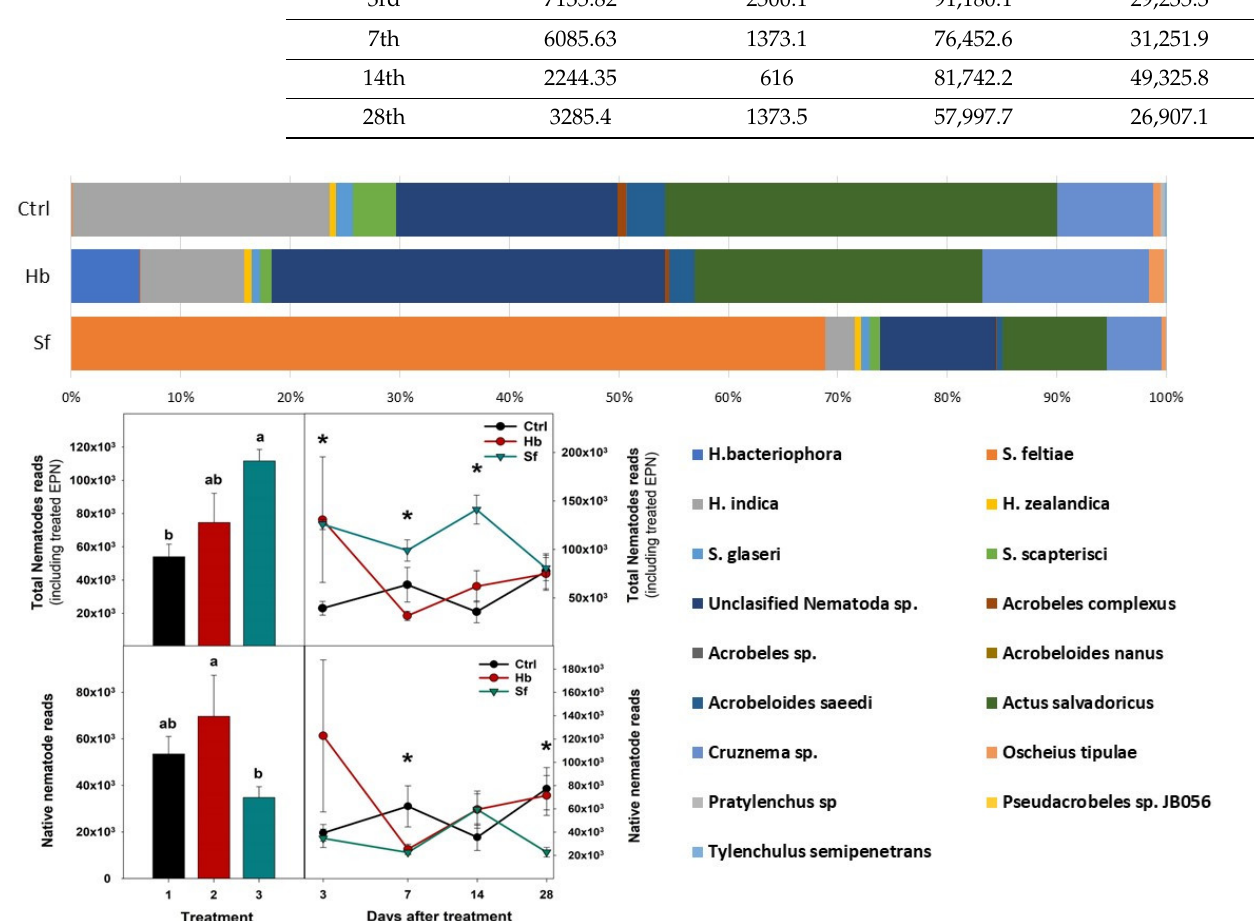
Figure 1. Results of DNA metabarcoding of nematode communities. Upper panel: Stacked bar plots showing the relative abundance of nematode species ( listed lower right ) detected in a citrus orchard for 28 days following augmentation with Steinernema feltiae (Sf) , Heterorhabditis bacteriophora (Hb) and an untreated control (Ctrl). Asterisks (*) indicate significant differences ( p < 0.05) between the treatments. Lower left: Two bar plots of the nematode read abundance in each treatment: upper bar plot is of total nematode reads (augmented plus native species) and lower bar plot depicts reads of native species only. Lower center: Temporal trends in nematode read abundance in the treatments for 28 days following augmentation. Error bars are standard errors of the mean, bars with the same letters do not differ ( p <